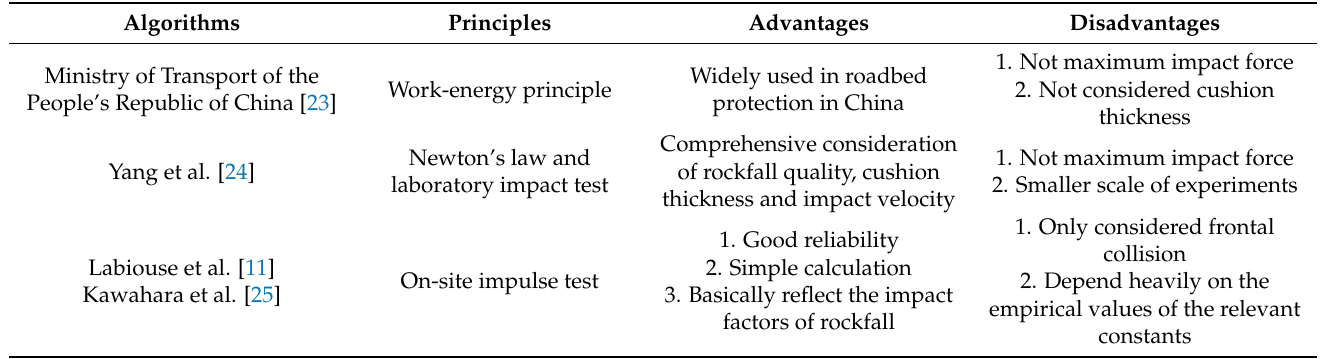
Table 1. Comparison of common impact force